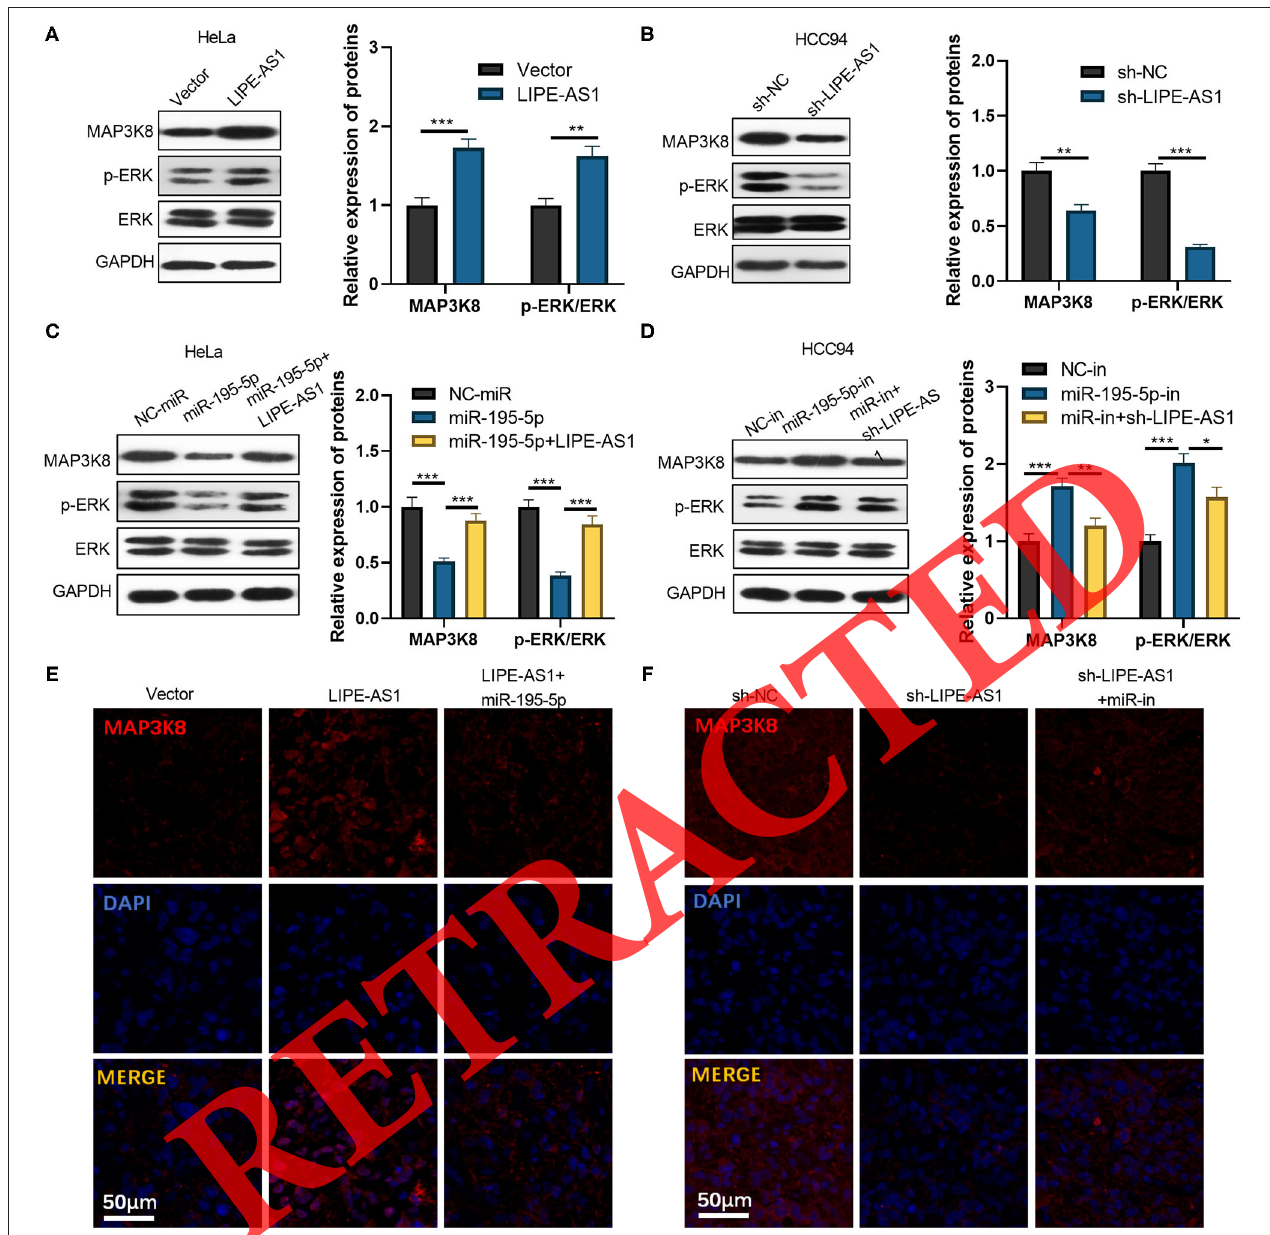
FIGURE 7 | The effect of LIPE-AS1/miR-195-5p on the MAPK/ERK pathway. LIPE-AS1 over- and low-expressing cell models were constructed in HeLa (A) and HCC94 cells (B) , respectively. Western blot was used to measure MAP3K8 and ERK protein expression in the cells. (C,D) Transfection of cervical cancer cells with miR-195-5p mimics and inhibitors, LIPE-AS1 over-expressed plasmid or sh-LIPE-AS1. Western blot was taken to measure the protein expressions of MAP3K8 and ERK in cells. (E,F) Tissue immunofluorescence was carried out to detect MAP3K8 in the tumor tissues (the grouping was the same as Figure 5 ). * P < 0.05, ** P < 0.01, *** P < 0.001. N =